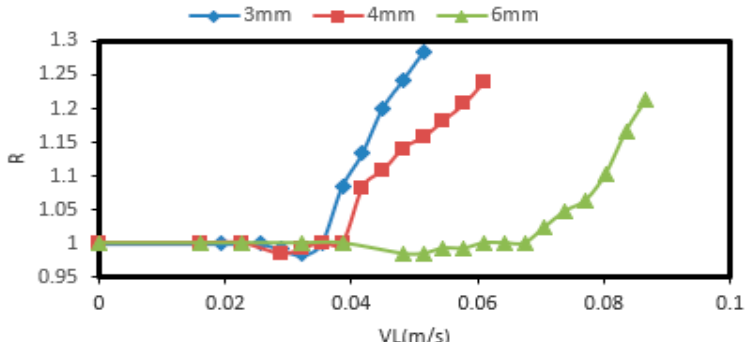
Figure 5. Variation of bed expansion ratio with liquid velocity for various particle diameters.